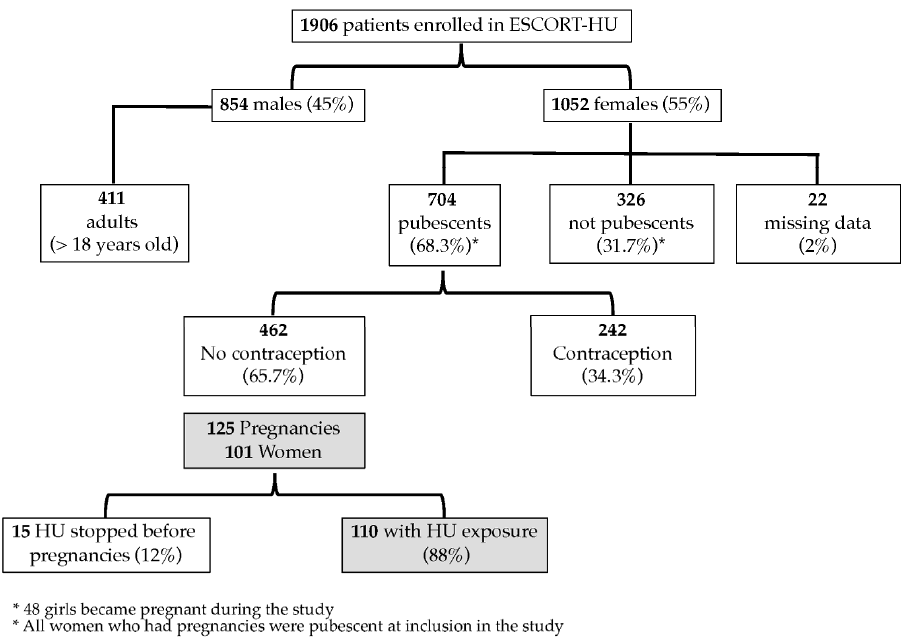
Figure 1. Clinical trial flowchart.